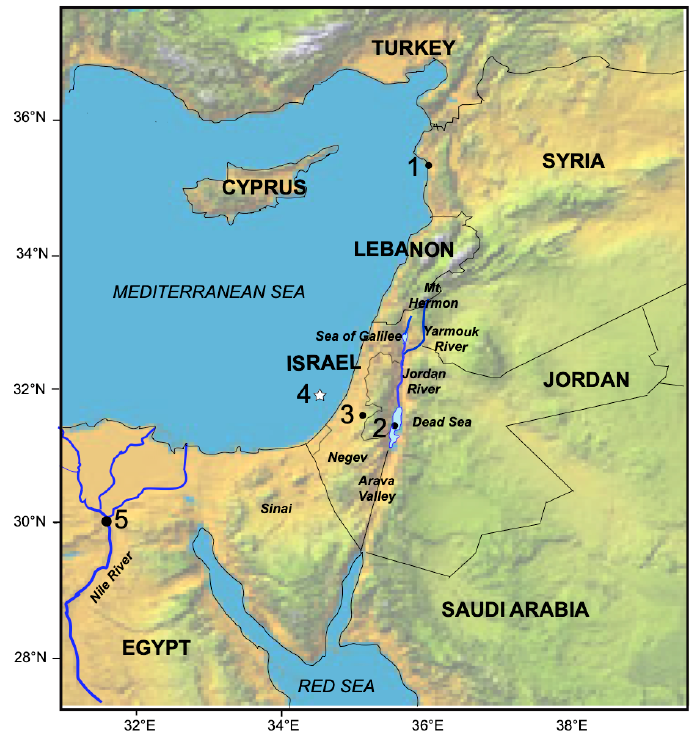
Figure 1. Regional map of the Levant showing the geographical features discussed in Sections 2 and 3 of the paper. The numbered bold dots indicate the locations of the paleoclimate archives discuss in Section 3: (1) Jableh (the location of the sediment core described in reference [3]; (2) The Dead Sea (the black dot is where the deep core discussed in references [4] and [5] was extracted); (3) The Soreq Cave [6]; (4) The marine sediment core [7]; (5) The Cairo Nilometer [8,9]. The figure was modified after Gasse et al. [10].